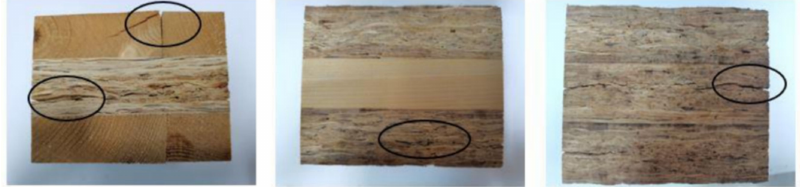
Figure 7. Typical failure modes of CLT and HCLT specimens during delamination